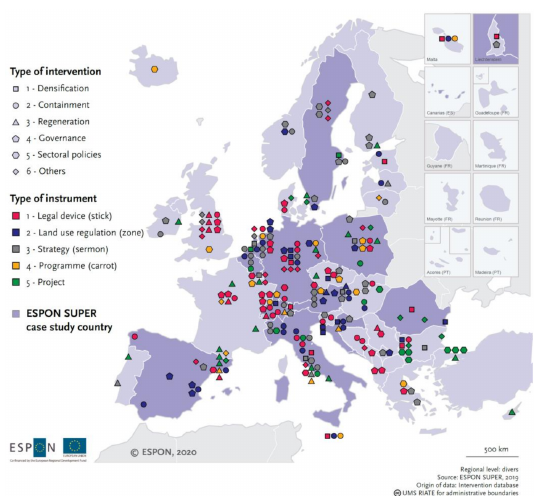
Figure 3. The localization of the SUPER intervention throughout Europe (source: [25] (p.